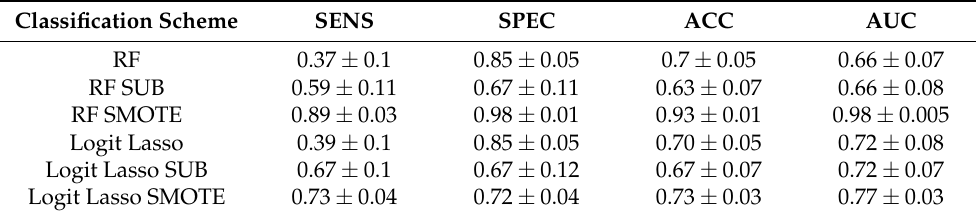
Figure 3. Performance metrics for the hold-out test for each classification scheme: violin plots of the distributions of the sensitivity values ( A ), specificity values ( B ), accuracy values ( C ), and AUC values ( D ). Table 2. Performance of the ML models for for the cross-validation sets (mean ± std). Classification